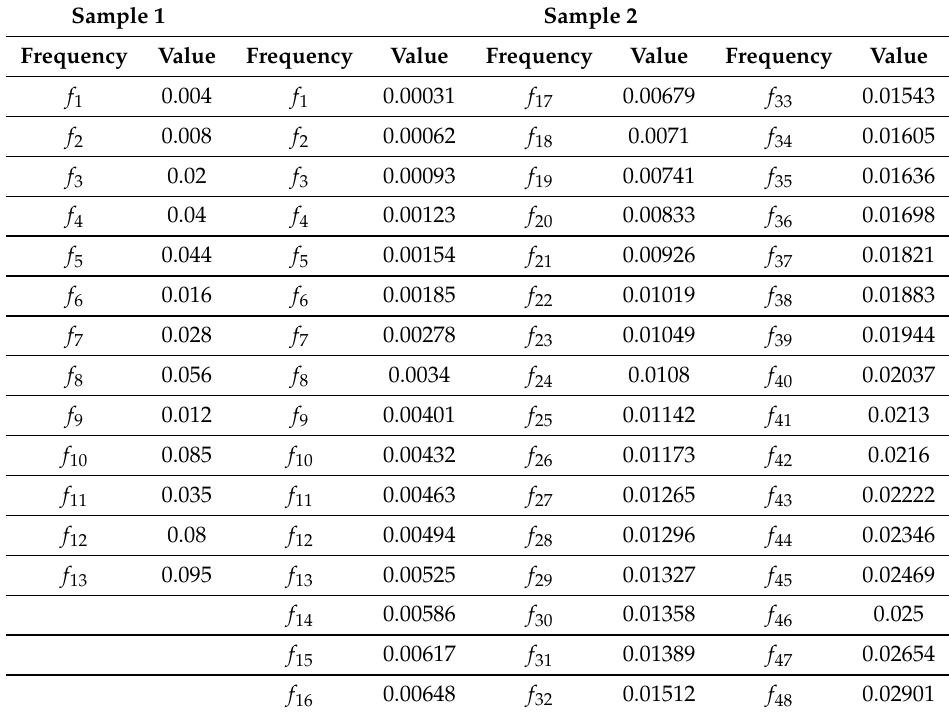
Table A1. Significant frequencies of H s series in